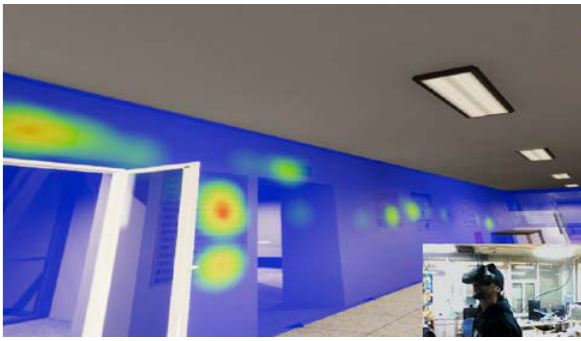
Figure 6: Screenshot from one of the tests.